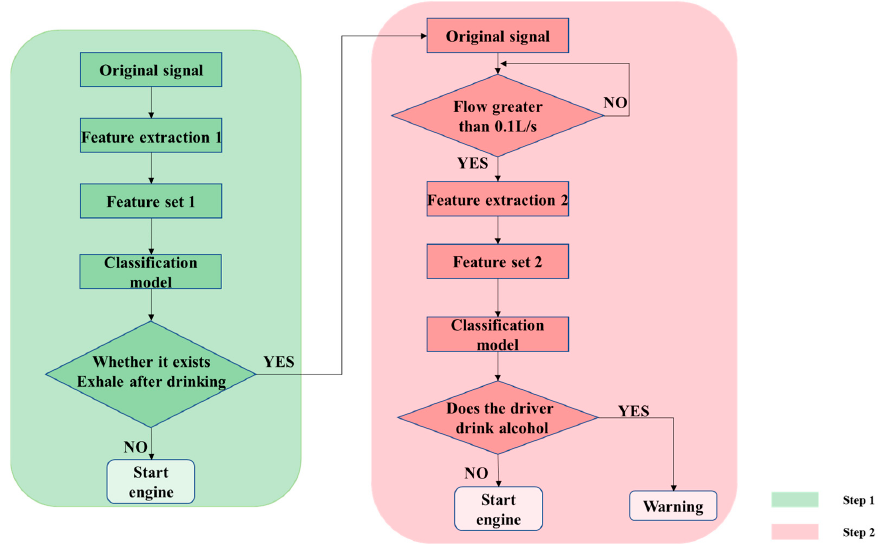
Figure 1. Schematic diagram of a two-step detection framework for onboard drunk driving of shared vehicles. shared